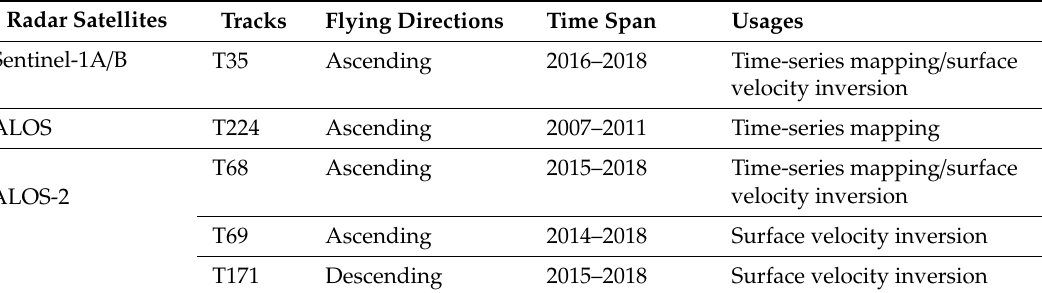
Table 1. Spaceborne SAR datasets and usages.